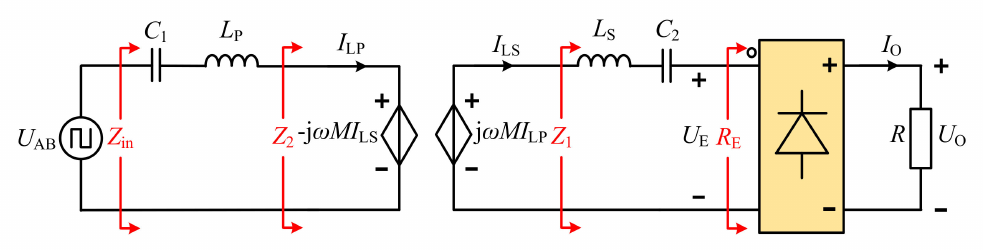
Figure 4. The equivalent circuit of the proposed WPT system.